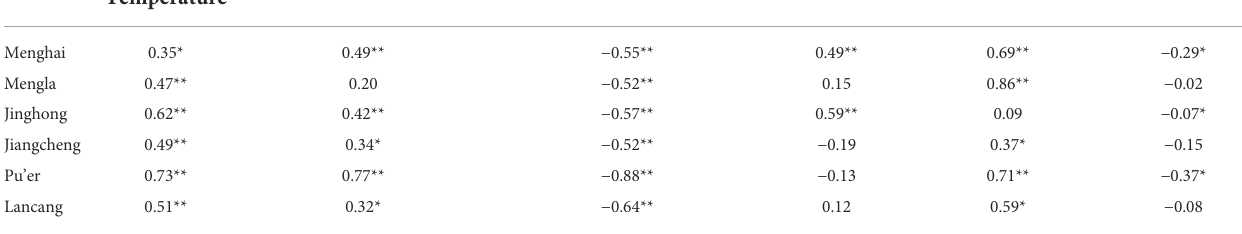
TABLE 4 Linear correlation coef fi cient between ET 0 of each station and annual mean meteorological elements. Sites